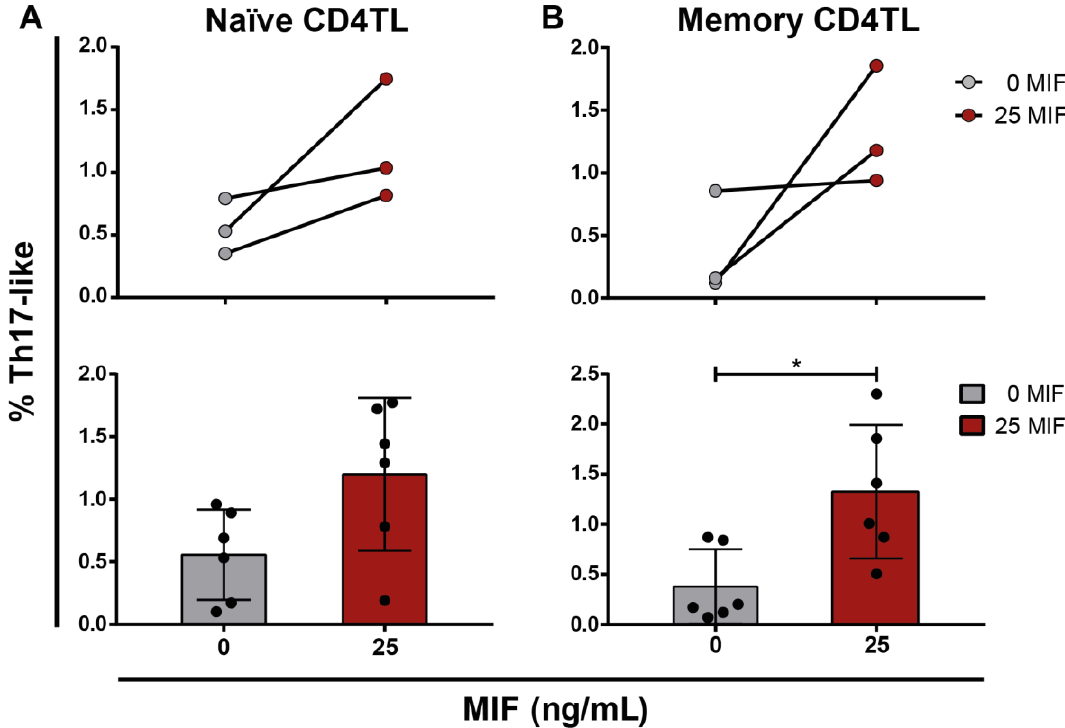
Figure 6. Study of the response of naïve and memory (CD4TL populations to MIF stimulus. Propor- tion of IL-17A expressing CD4TL in cell co-cultures performed with BAL R5-infected MDMs and: ( A ) sorted naïve CD4TLs (CD45RA + CCR7high) and ( B ) sorted memory CD4TLs (CD45RO + CCR7 − ). Individual experiments mean values (upper panel), all replicates (below panel). Data represent the mean ± SD of three independent experiments each one performed in triplicate. Data analysis was performed with a Student ’s t -test (* p < 0.05).